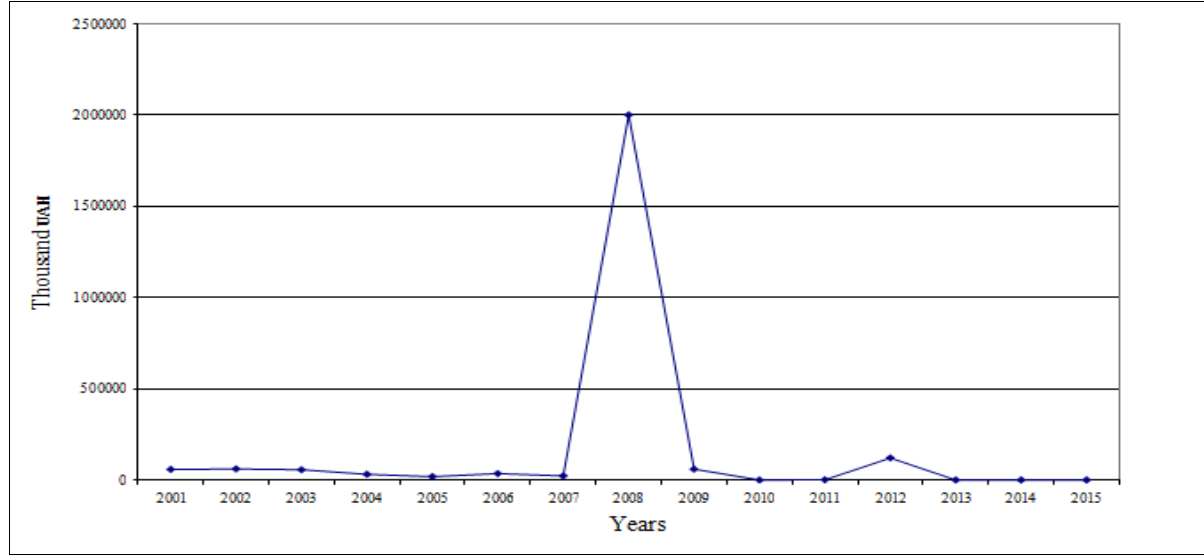
Fig. 3. Flow of state budget subventions from State budget of Ukraine to local budgets in order to overcome results of uninsured events over the period of